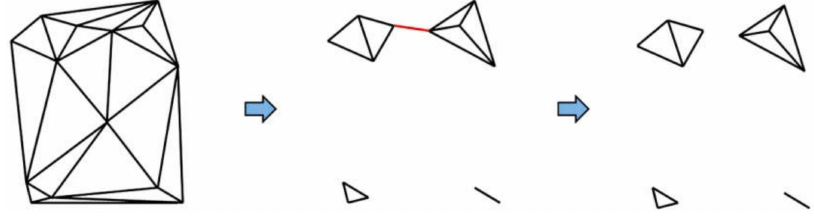
Figure 5. Procedure of Delaunay triangulation-based